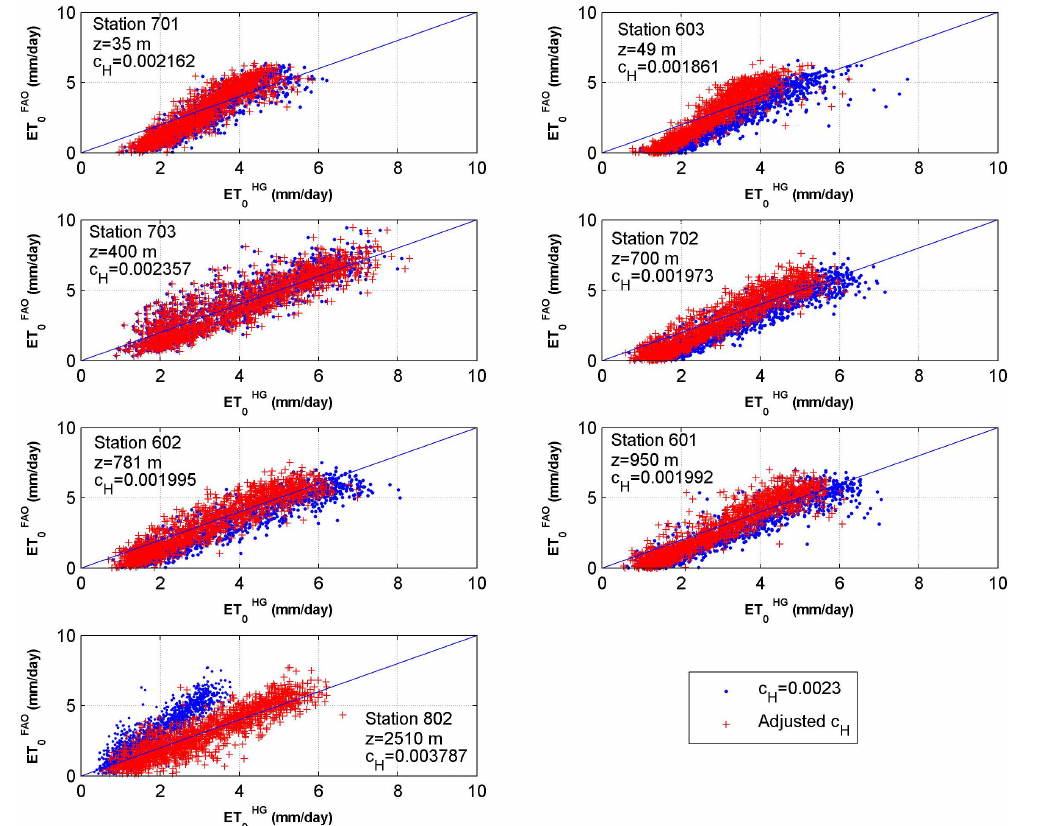
Fig. 4. Daily ET 0 (ET FAO ) vs. daily ET 0 by Hargreaves (ET HG ) with a constant coefficient (0.0023) and adjusted c H at each station (601, 0 0 602, 603, 701, 702, 703, 802) for the evaluation period (20 November 2004–31 August